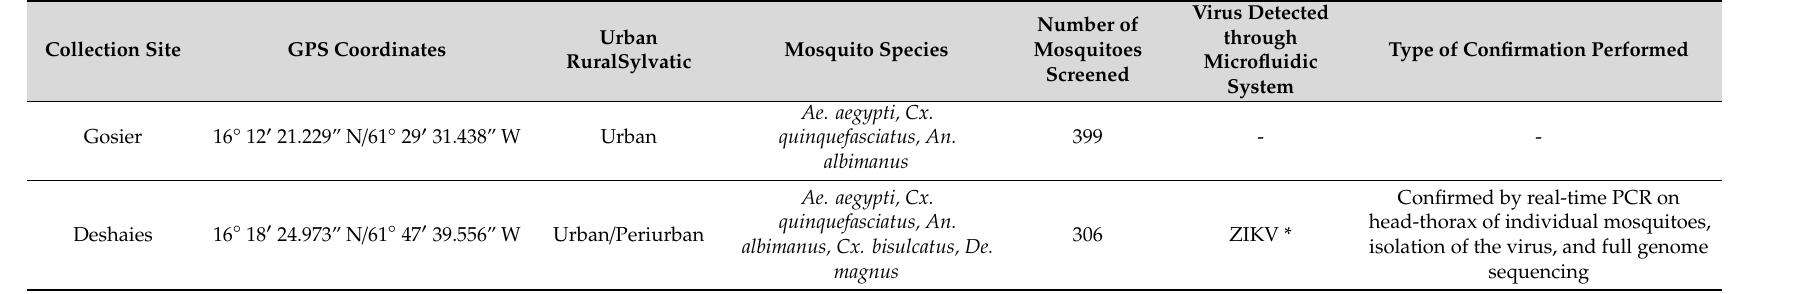
Table 4. Mosquito species, number of mosquitoes collected, and virus detected in